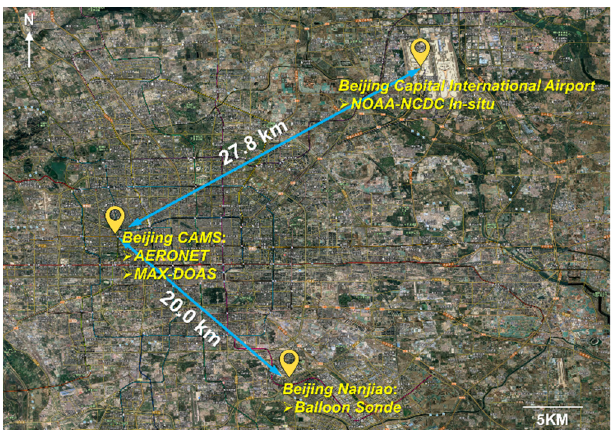
Figure 1. Location of the measurement sites in Beijing. The Multi-Axis Differential Optical Absorption Spectroscopy (MAX-DOAS) and Aerosol Robotic Network (AERONET) instruments are collocated at the CAMS, Beijing. The National Oceanic and Atmospheric Administration-NCDC in-situ instrument collects surface humidity measurements at Beijing Capital International Airport (BCIA). The balloon-borne radiosonde measurements are conducted weekly at Nanjiao Observatory, Beijing.